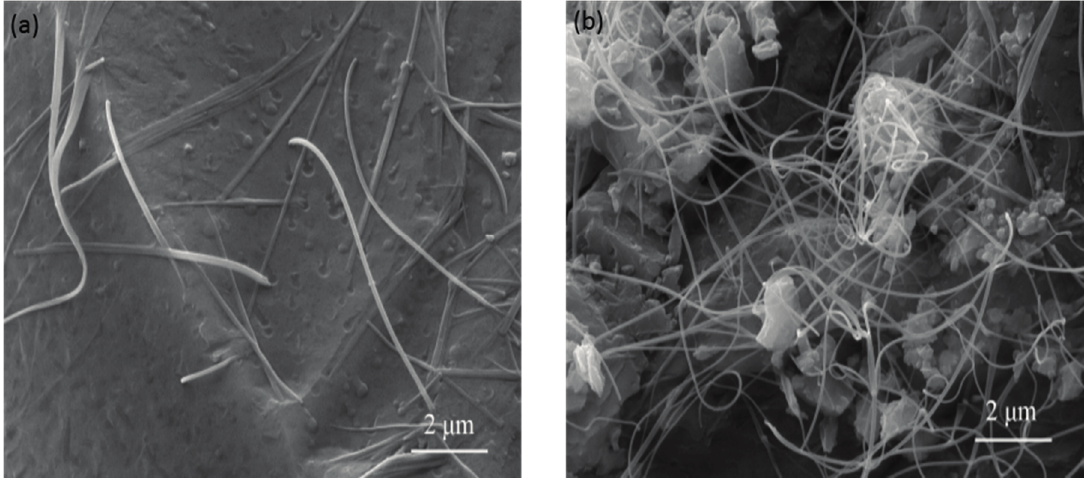
Figure 3. The surface morphology of ( a ) Di scaffold with 2 wt % MWCNTs; and ( b ) Di scaffold with 5 wt %